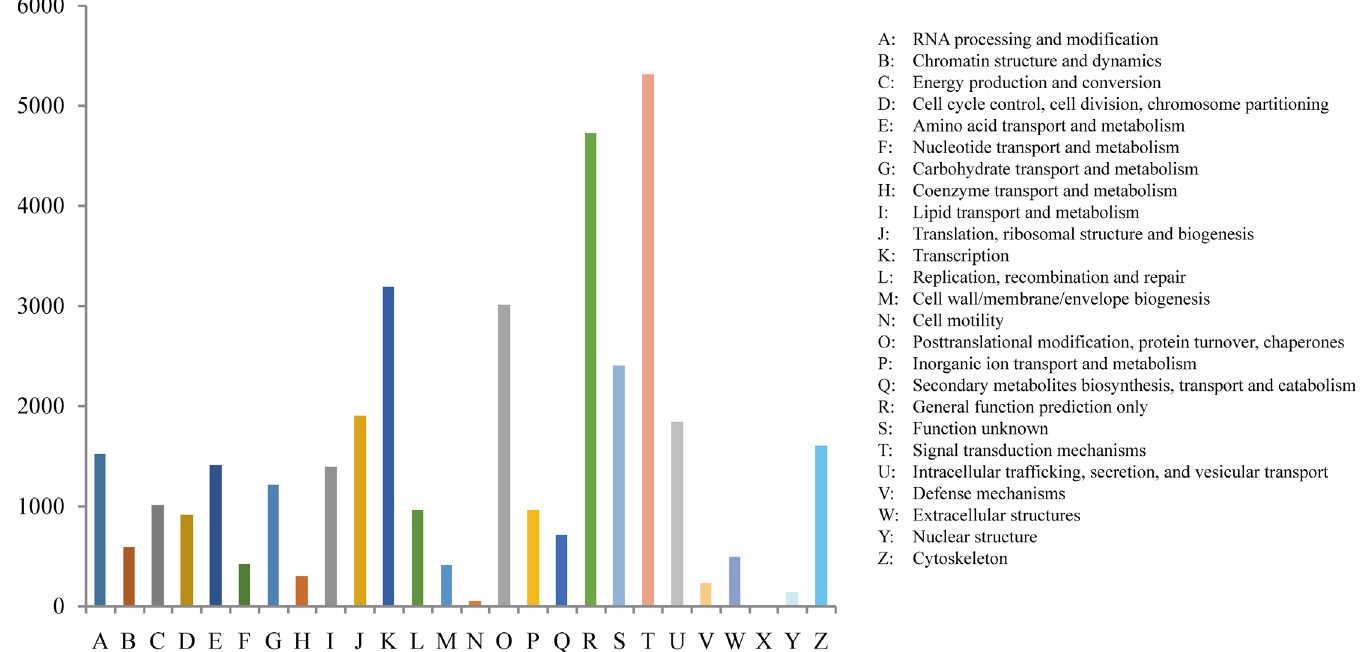
Fig 4. Histogram presentation of clusters of orthologous groups (KOG) classification. The X- axis is the KOG term. The Y-axis shows the number of unigenes.